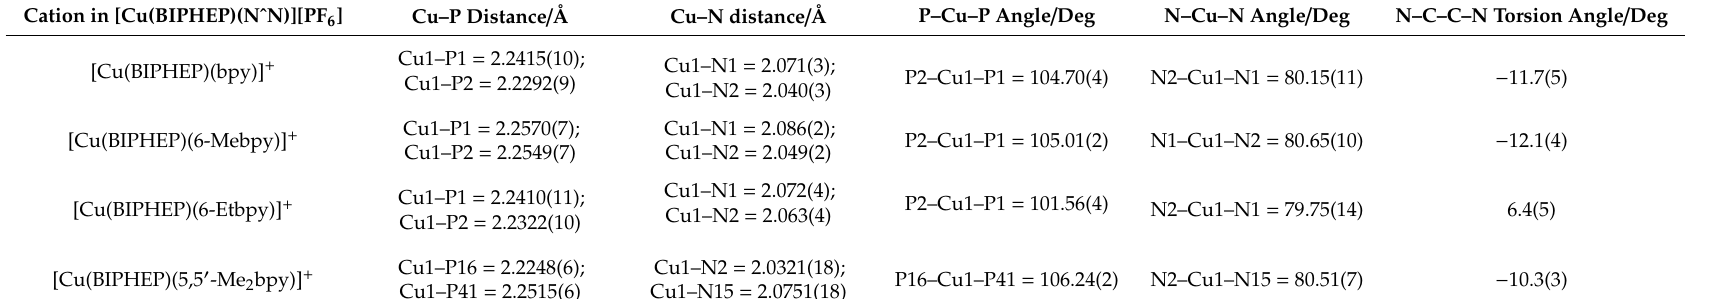
Table 1. Selected structural parameters for the [Cu(BIPHEP)(NˆN][PF 6 ] compounds.